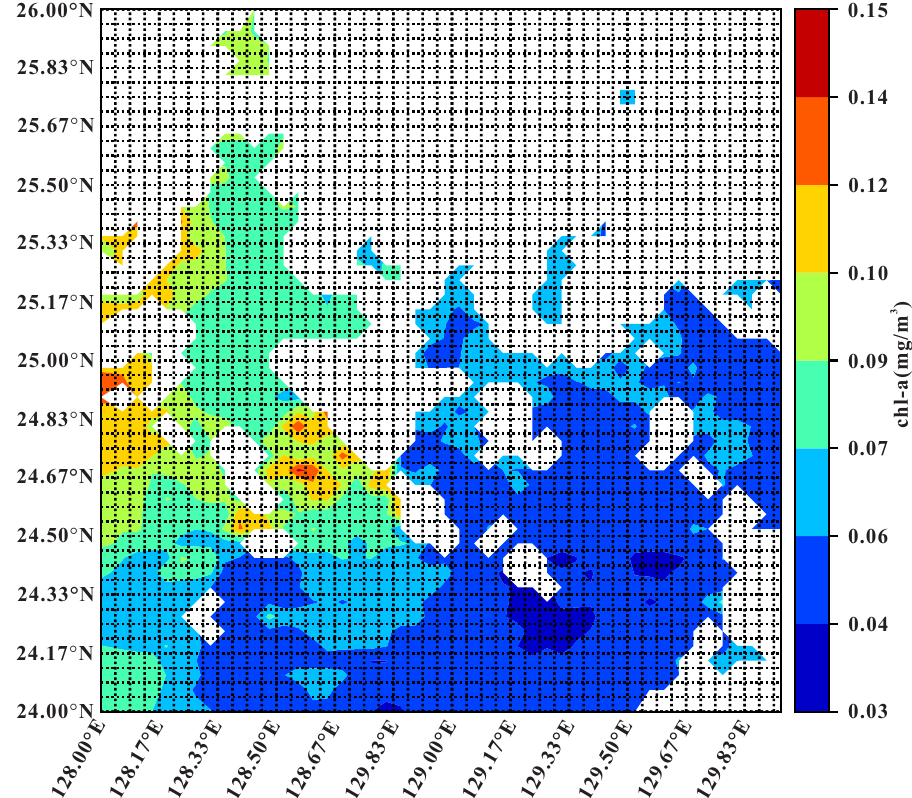
Figure 4. The spatial distribution of CHA-EAST dataset on 25 July 2021, where the white areas have no